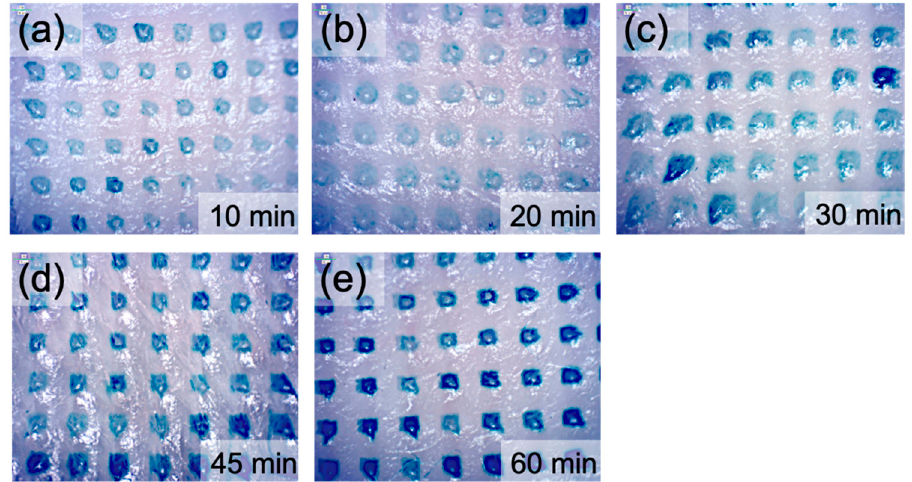
Figure 5. The effect of trypan blue release after the insertion of microneedles into a porcine cadaver skin. The images were performed at different time intervals at ( a ) 10 min; ( b ) 20 min; ( c ) 30 min; ( d ) 45 min; and ( e ) 60 min.